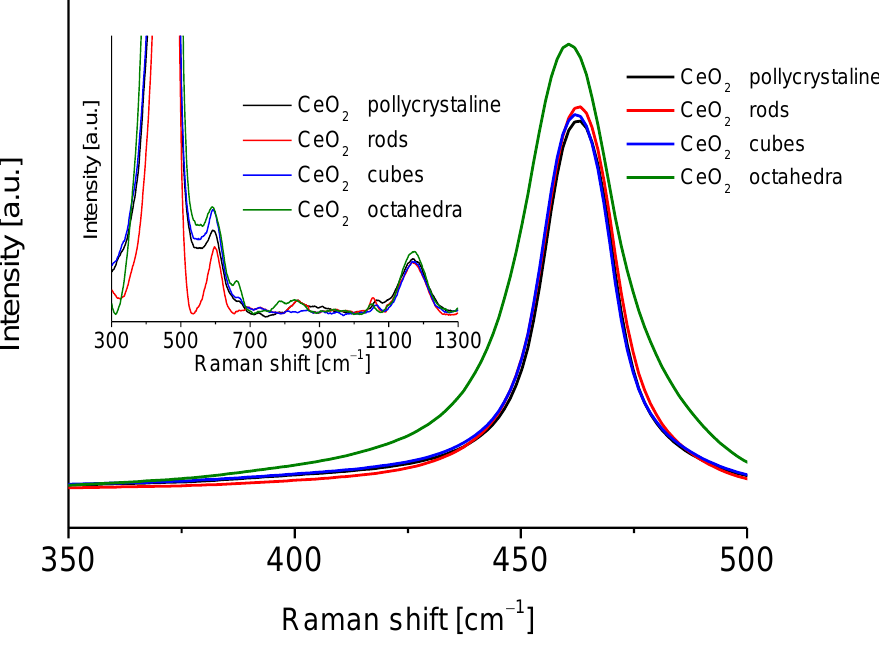
Figure 4. Raman spectra of the cerium dioxide shapes.